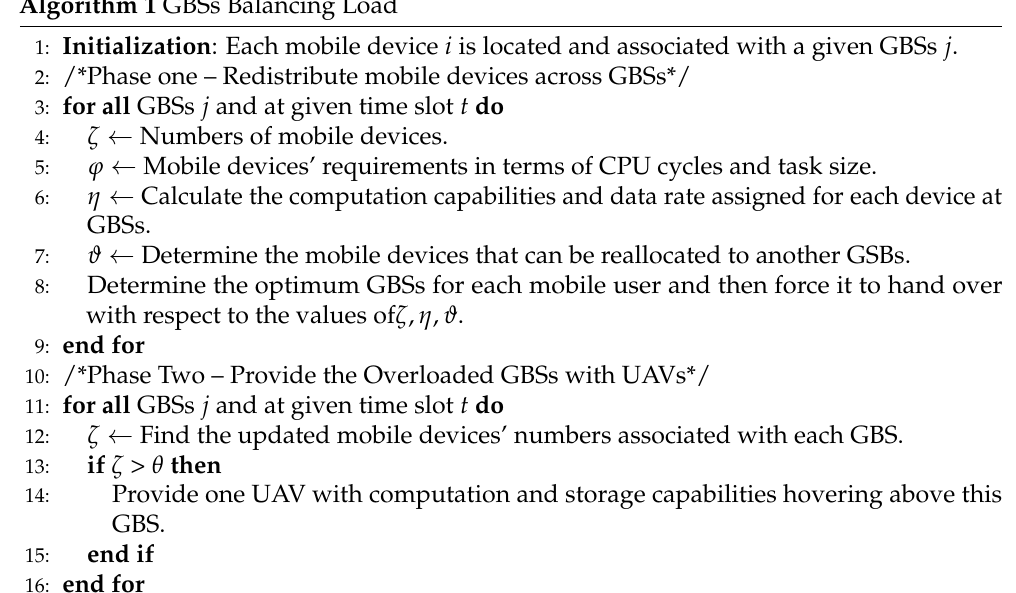
Algorithm 1 GBSs Balancing